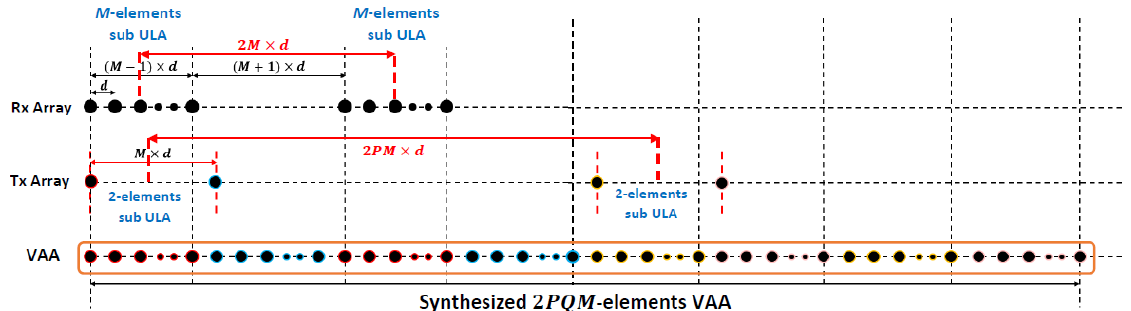
Figure 2. Proposed general VAA schematic diagram.